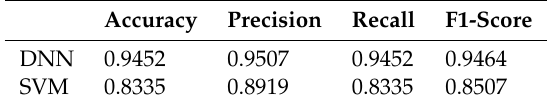
Classification performance of the deep neural network (DNN) and support vector machine (SVM) on holdout data. Precision, recall and F1-scores are reported as weighted averages. Accuracy Precision Recall